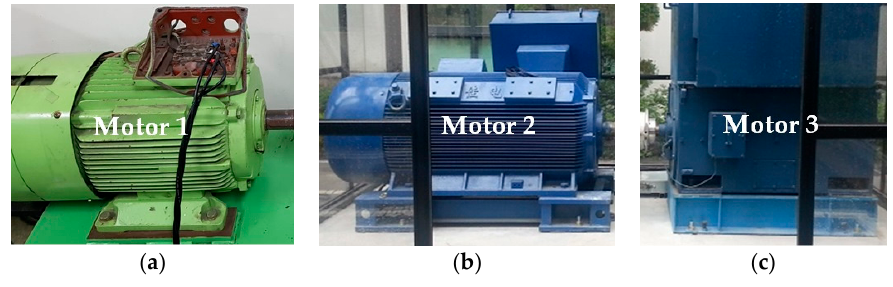
Figure 9. Induction motors ( a ) Motor 1 ( b ) Motor 2 ( c ) Motor